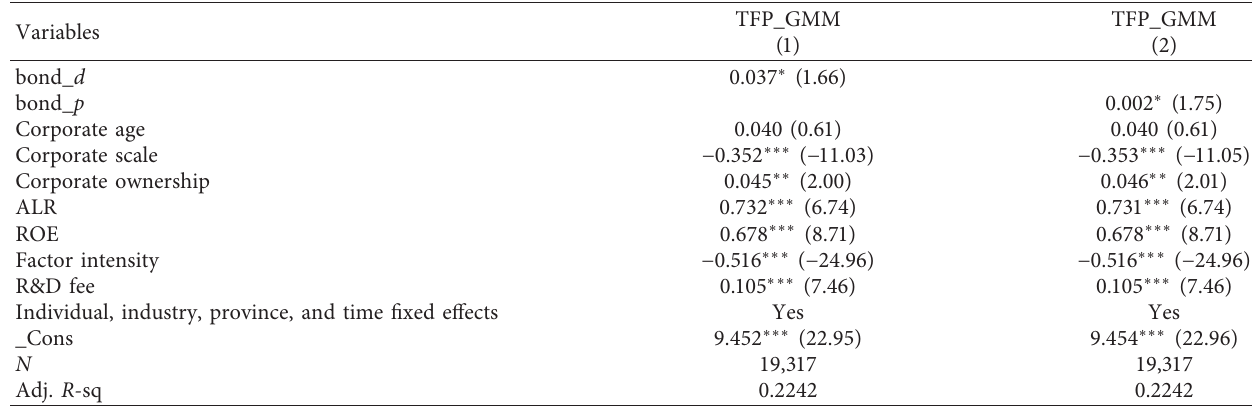
Table 3: Regression results of robustness